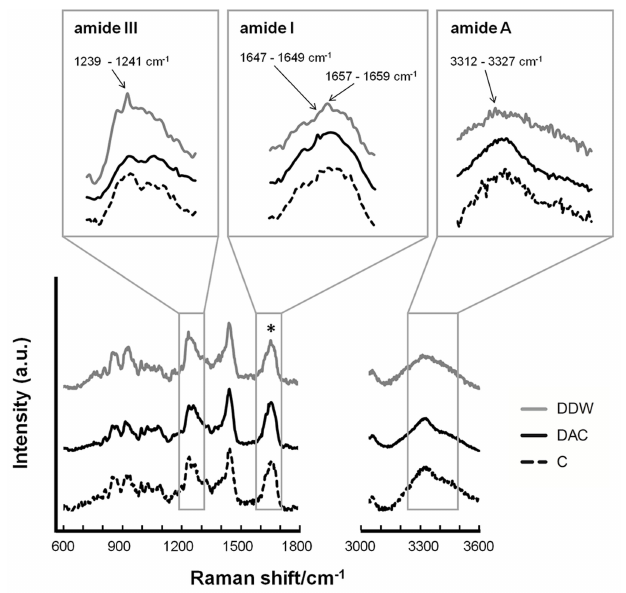
Figure 2. Structural characteristics of collagens. Raman spectra of DDW-, DAC- and commercial collagen (C) were normalized to the amide I band at around 1660 cm − 1 (the peak marked as *).